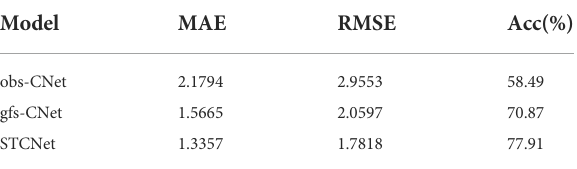
FIGURE 11 RMSEs of different methods for 2-m temperature forecasting in different months and at different stations. TABLE 4 Comparison of different methods regarding hourly 2-m temperature forecasting.